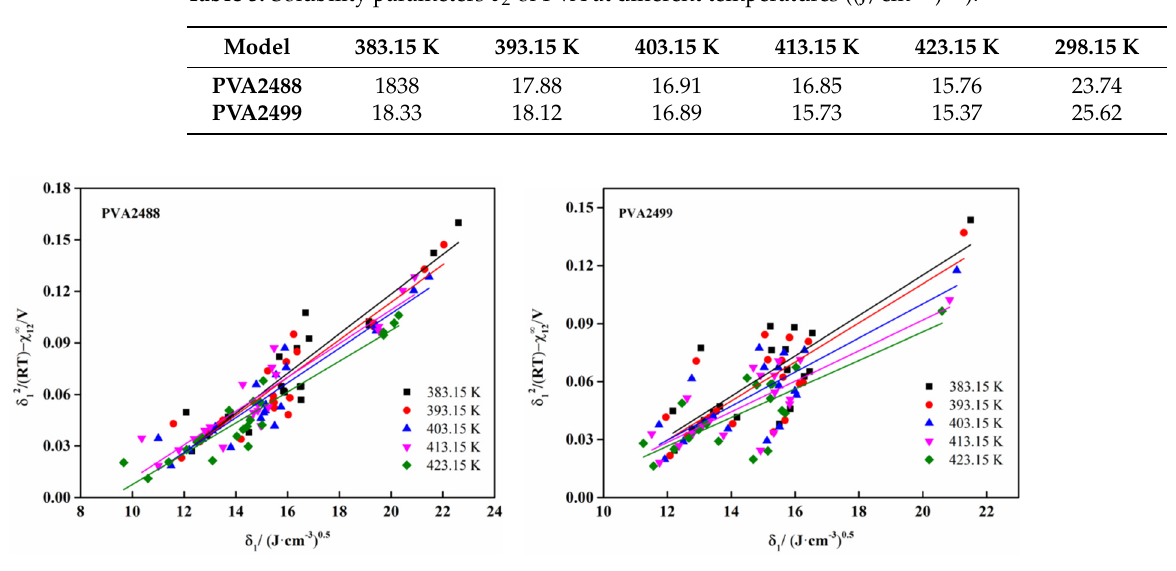
Figure 2. (cid:2964) Figure 2. δ